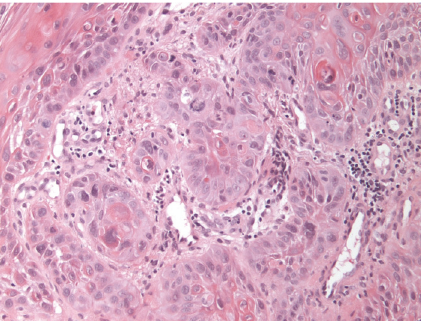
Figure 3: Biopsy of esophageal mass showing invasive squamous cell